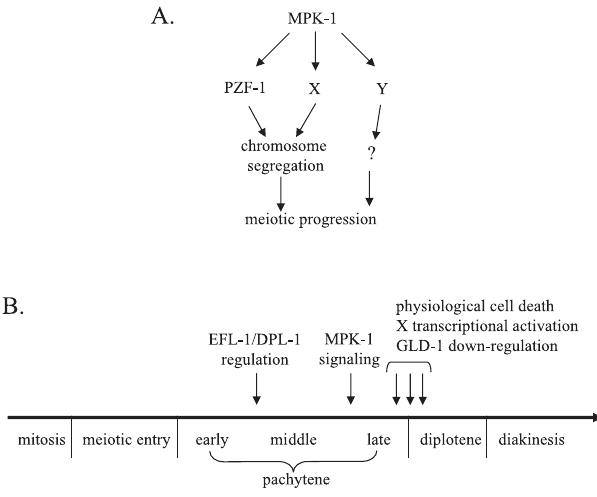
Figure 8. MPK-1 Signaling in the Germ Line (A) Model of multiple MPK-1 signaling-dependent effectors acting together to promote meiotic progression. X and Y represent putative proteins that function downstream of MPK-1. Additional processes besides chromosome segregation that contribute to meiotic progression are indicated by the question mark. (B) Representation of events in germ line development. MPK-1 signaling occurs downstream of EFL-1/DPL-1 gene regulation, but prior to physiological germ cell death, X chromosome transcriptional activation, and GLD-1 down-regulation.